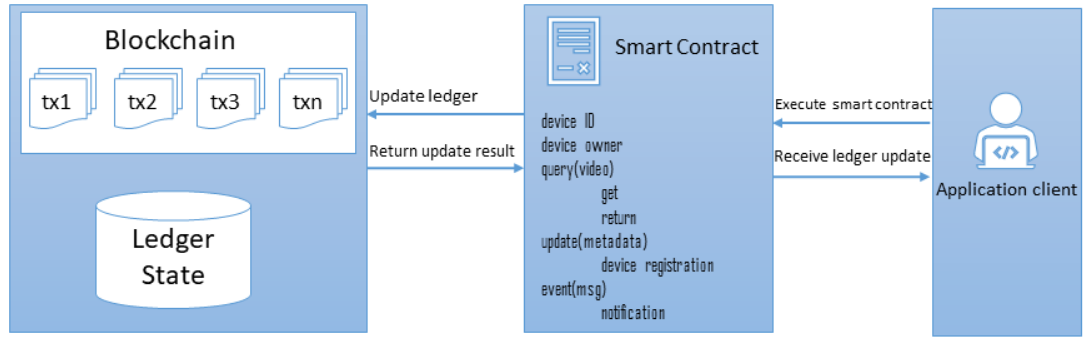
Figure 5. Smart contract for a CCTV–blockchain